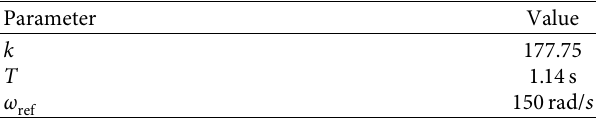
Table 1: System parameter values of a frst-order DC motor